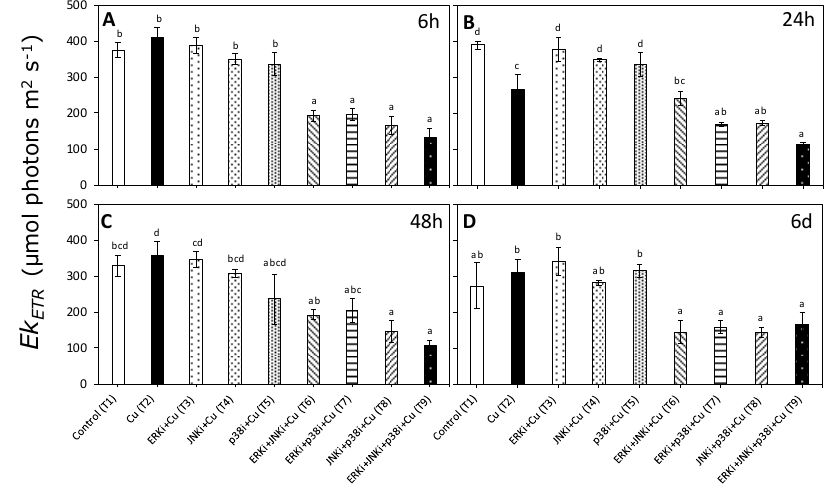
Figure 5. Saturation of the irradiance of ETR (EkETR) in U. compressa under copper and/or exposure to MAPK inhibitors. Treatments: T1—control only with seawater; T2—copper only exposure as 10 µM CuSO 4 (Cu); T3—copper + 5 µM MAPK ERK inhibitor PD98059 (Cu + ERKi); T4—copper + 5 µM MAPK JNK inhibitor SP600125 (Cu + JNKi); T5—copper + MAPK p38 inhibitor SB203580 (Cu + p38i); T6—Cu + ERKi + JNKi; T7—Cu + ERKi + p38i; T8—Cu + p38i + JNKi; and T9)—Cu + ERKi + JNKi + p38i. Samples were analyzed after ( A ) 6 h, ( B ) 24 h, ( C ) 48 h, and ( D ) 6 d of treatment. Different letters within each graph represent significant differences at the 95% confidence interval ( p < 0.05). Plots are mean ± SE ( n = 3).